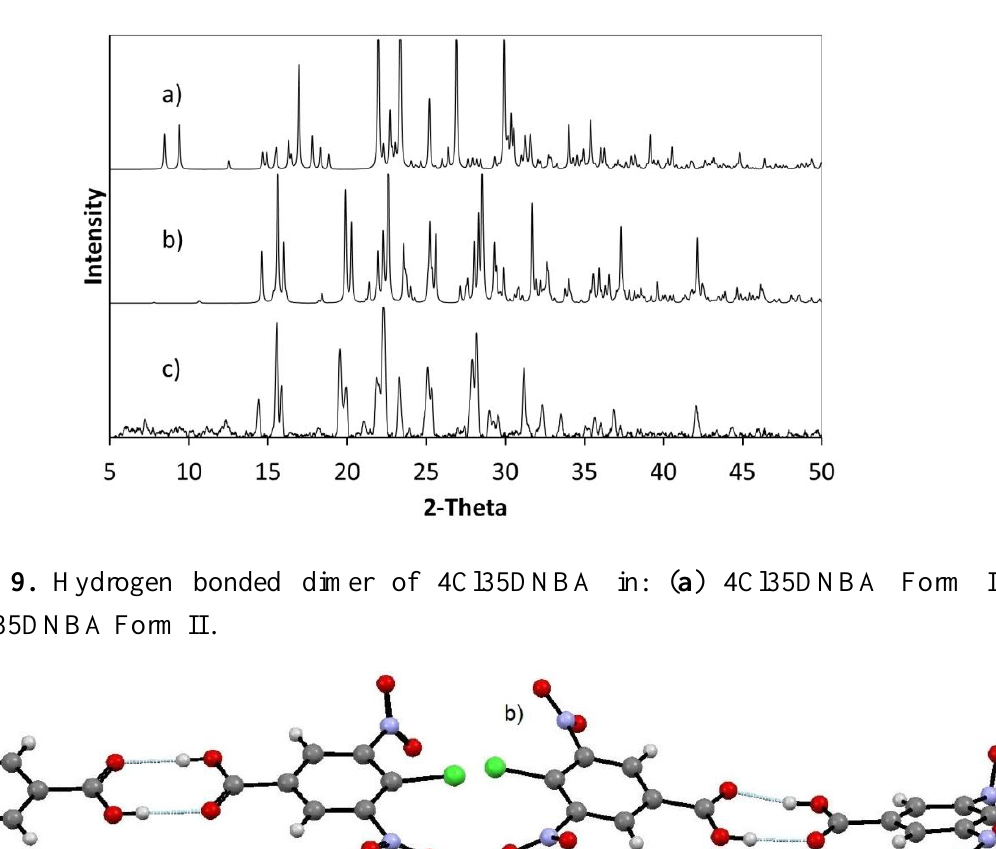
Figure 8. PXRD patterns of ( a ) 4Cl35DNBA Form I (calculated from SXRD structure); ( b ) 4Cl35DNBA Form II (calculated); ( c ) 4Cl35DNBA Form II (as supplied from